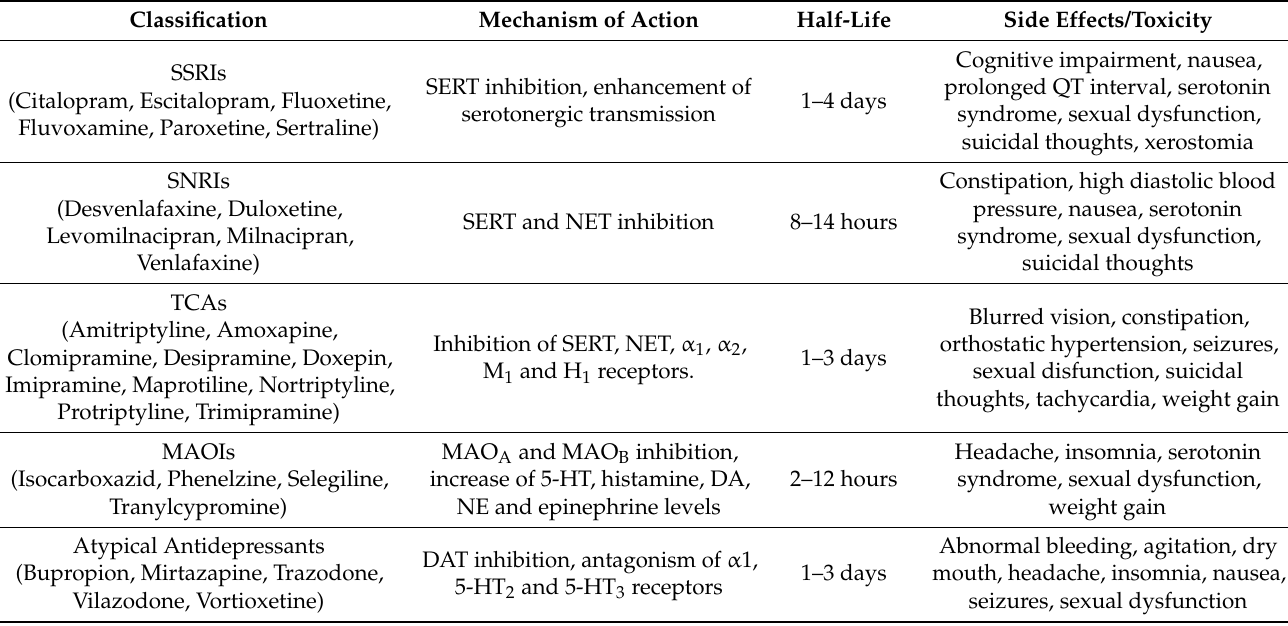
Table 1. Classification, mechanisms of action, and side effects of antidepressant drugs.